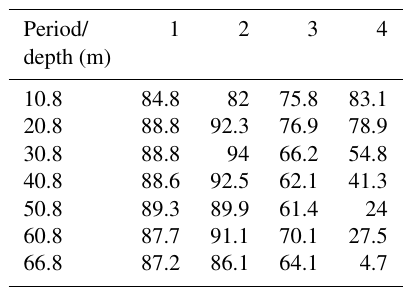
Table 2. Persistency (%) of the measured currents at the ADCP lo- cation at the selected depths during the selected periods: 1 to 21 March (1); 27 May to 4 June (2); 10 to 25 June (3); 2 to 10 July